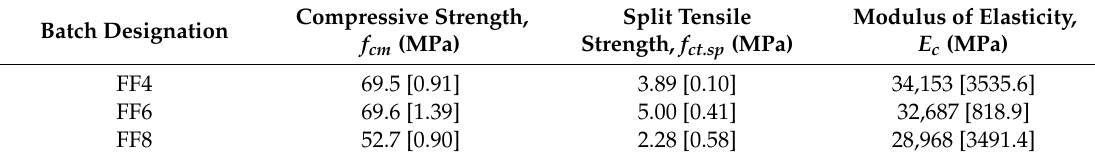
Table 4. Summary of the 28-day test results. Numbers in square brackets are standard deviation.